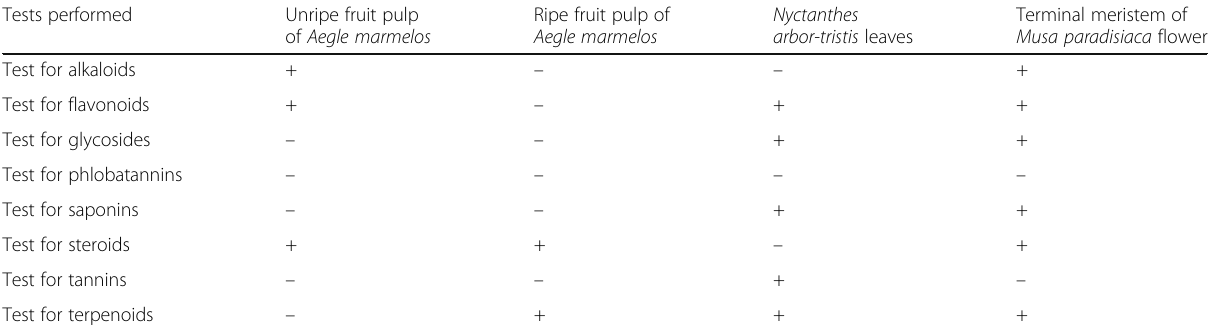
Table 1 Results of preliminary phytochemical analysis of methanolic extracts of unripe fruit pulp of Aegle marmelos , ripe fruit pulp of Aegle marmelos , leaves of Nyctanthes arbor-tristis, and the terminal meristem of Musa paradisiaca flower. (+: present, − : absent) Tests